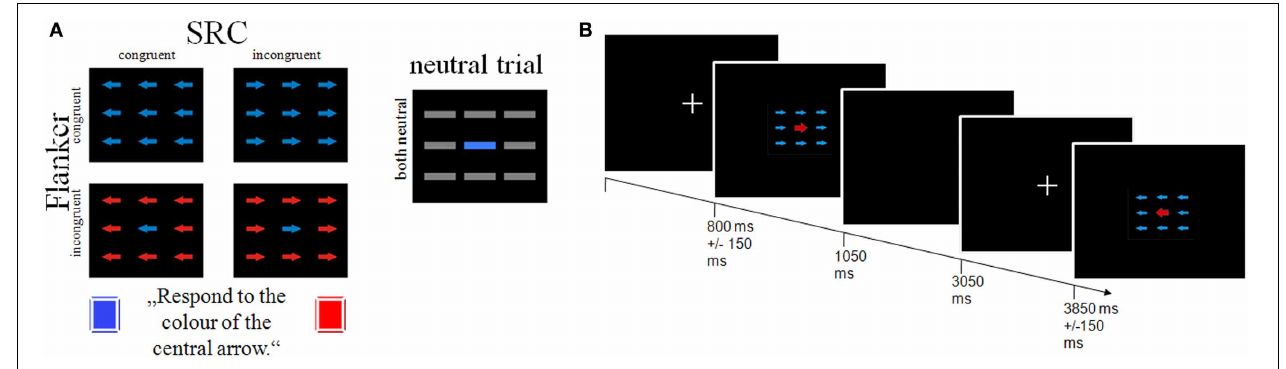
FIGURE 1 | Schematic illustration of the study design. (A) The combination of the Flanker and SRC task results in four conditions: a Flanker and SRC congruent condition (FcSc); a Flanker congruent and SRC